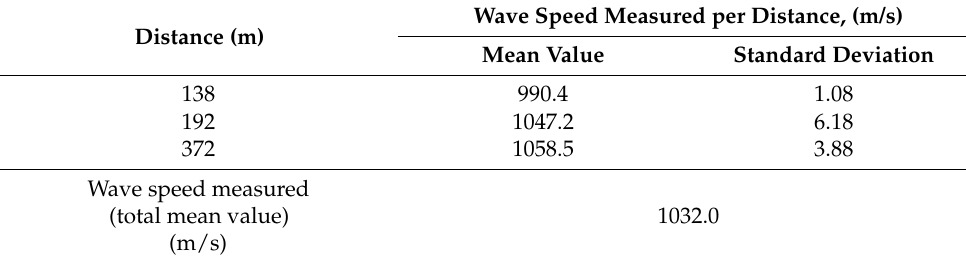
Figure 8. Wave speed measured with respect to some distances from impact location. Table 2. Wave speed measured.